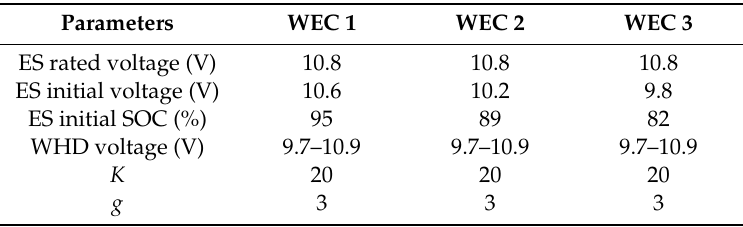
Table 5. Experimental initial parameters.